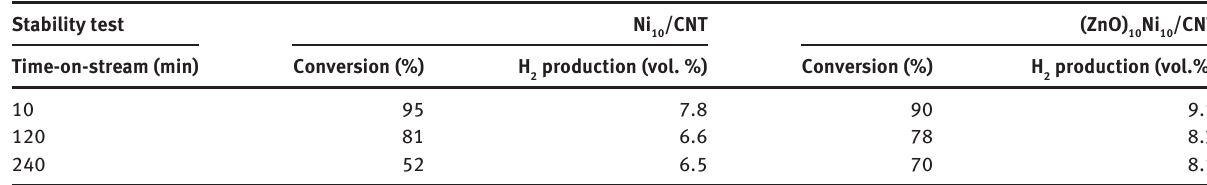
Table 5: Stability of the Ni (vol.%) at 400 ° C as a function of time on stream.